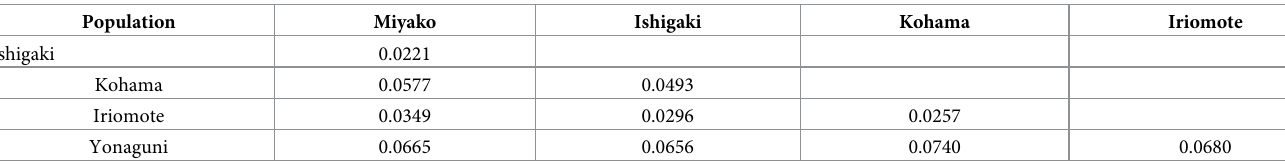
Table 3. Fst between